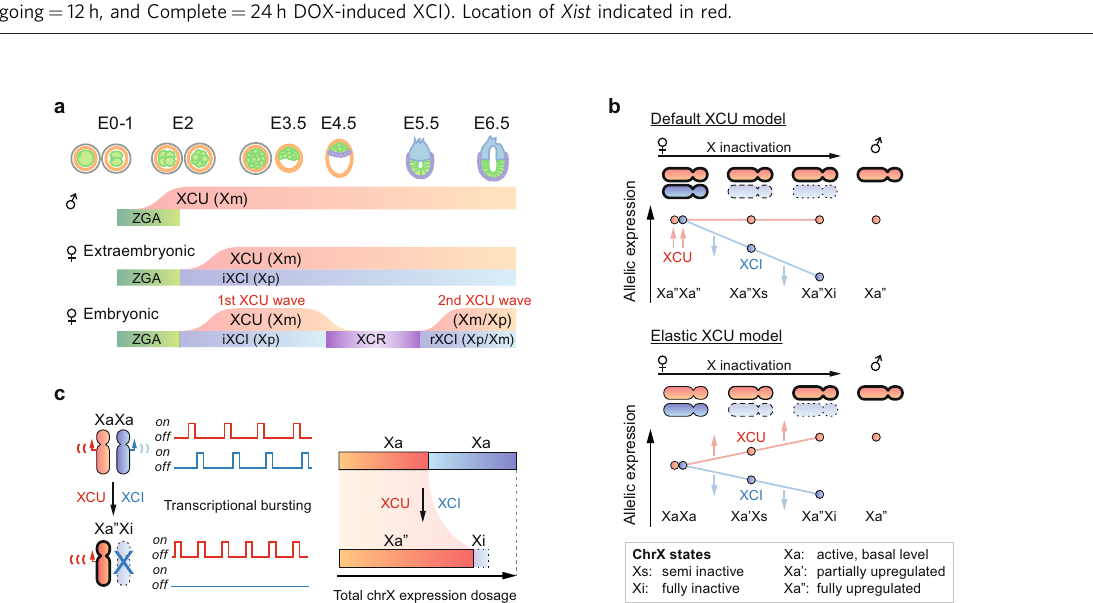
Fig. 4 Tracking epigenetic features of the X chromosome upon upregulation establishment. a Schematic overview of the experimental setup. C57BL6/ J × CAST/EiJ F1 hybrid male and female mESCs were primed into EpiSCs using Activin A and FGF2 for up to 7 days to induce XCI. Cells were collected at conditions and days of priming as indicated and subjected to single-cell multi-modal pro fi ling of expression (Smart-seq3) and chromatin accessibility (scATAC). See Supplementary Data 1 for cell annotations. b Heatmap of accessibility changes along EpiSC priming. Acc. gene accessibility score. c Genome tracks of representative genes changing accessibility along EpiSC priming. Shown as single-cell accessibility and merged pseudobulk tracks. d UMAP dimensionality reductions for accessibility (top 25,000 features), expression (top 1000 HVGs), or the combined dimensions per cell ( n = 1619). For combined coordinates, cells are also shown colored based on binned XCI completion (female cells only), or accessibility/expression levels of Klf2 and Aif1l . e Maternal ratios for imprinted genes based in scRNA-seq (y-axis) and scATAC-seq (x-axis). Detection detected in fraction of cells. The center ellipse indicates 95% con fi dence interval for all genes. f Genomic tracks of allelic pseudobulk accessibility for representative genes from e . g Genomic tracks of allelic pseudobulk accessibility for the entire X chromosome. Cells grouped based on XCI state and sex with the corresponding expression of chrX shown as box plots to the right. X alleles indicated as active (Xa), inactive (Xi), or semi-inactive (Xs) based on X-chromosome allelic expression bias. h Rolling average of accessibility and expression (TPM) across each X allele, grouped based on the degree of XCI completion (None = 0 – 20%, Ongoing = 20 – 80%, and Complete = 80 – 100% allelic bias). Allelic native ChIP-seq shown for permissive H3K4me1 and repressive H3K27me3 histone modi fi cations (where None = 0 h, Ongoing = 12 h, and Complete = 24 h DOX-induced XCI). Location of Xist indicated in red.